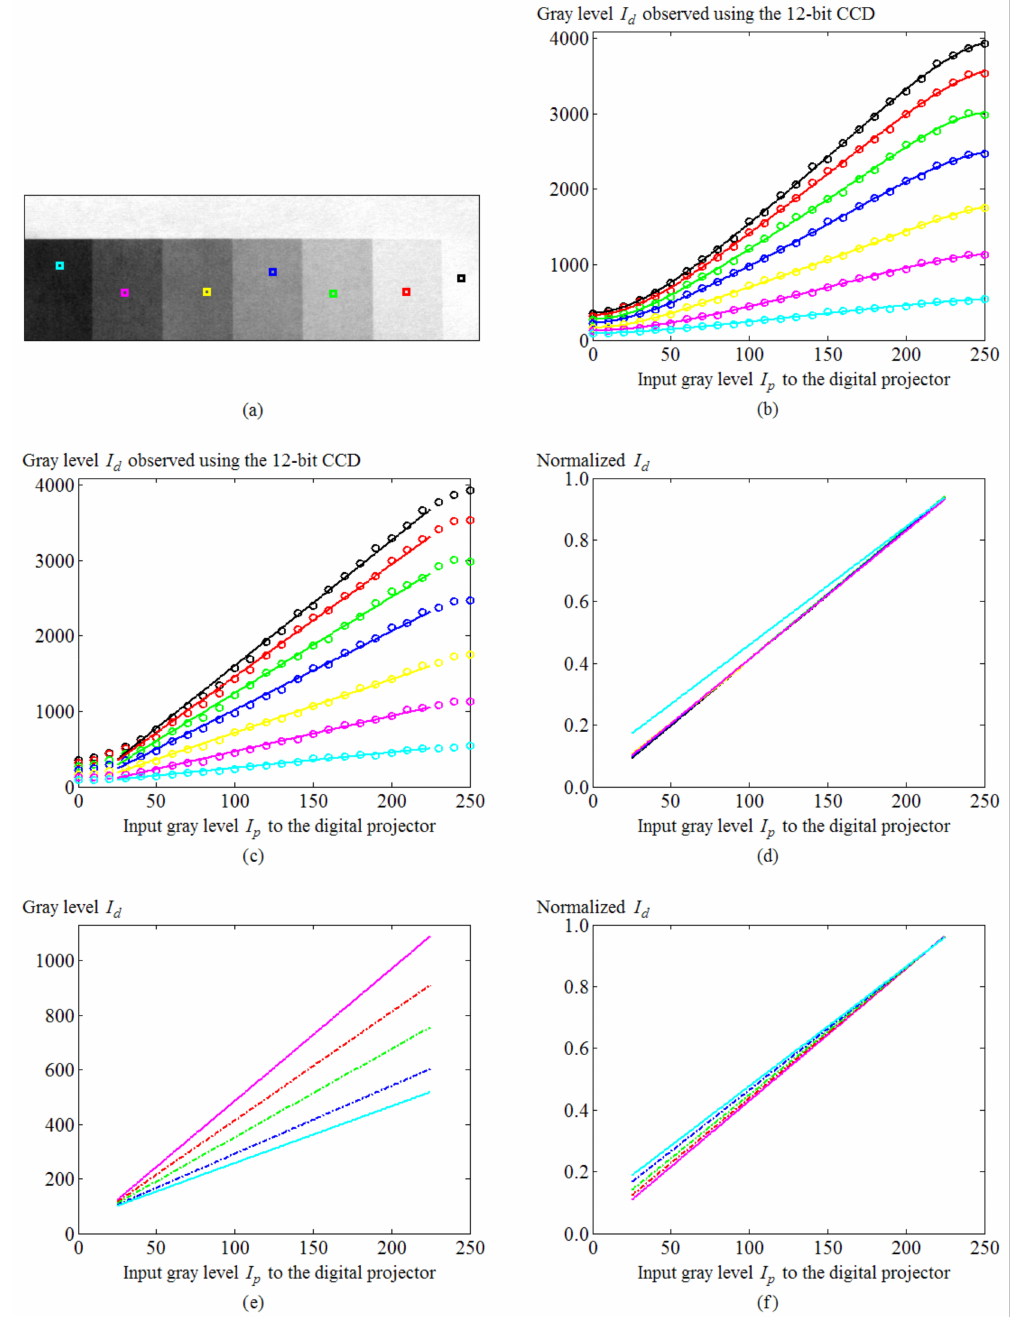
Figure 5. ( a ) A piece of paper textured with various reflection coefficients, in which a couple of pixels framed with various colors were selected as the inspected samples. ( b ) Data points and fitted curves depicting the correspondences between the input gray levels and the observed gray levels for various sampled pixels, wherein the correspondences are plotted as the same colors as the framed pixels shown in ( b ). ( c ) Fitted lines for various sampled pixels in the linear area. ( d ) Fitted relationships between the normalized I p and input gray levels Id in the linear area. ( e ) A close-up view of the linear relationships sampled at the magenta-framed pixel and some other noisy pixels. ( f ) Relationships between the normalized I p and input gray levels I d